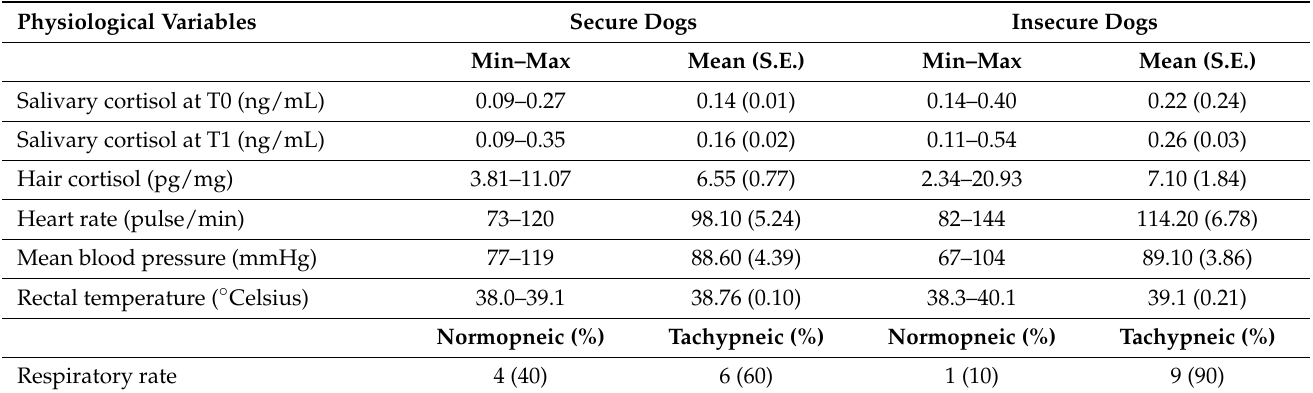
Table 2. Descriptive statistics of the physiological data in secure and insecure dogs.